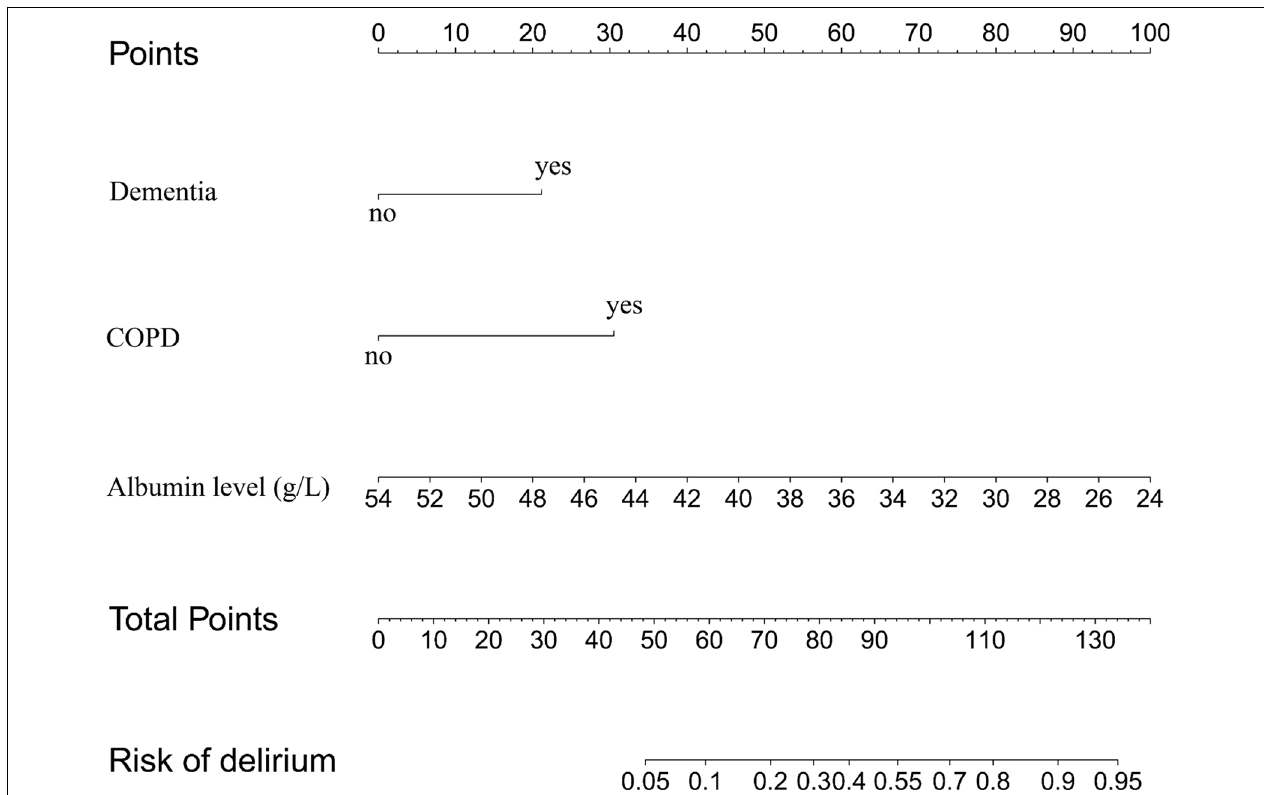
FIGURE 2 | The nomogram predicts the risk of POD in elderly patients with hip fractures, based on dementia, COPD, and ALB levels. COPD, chronic obstructive pulmonary disease; ALB,